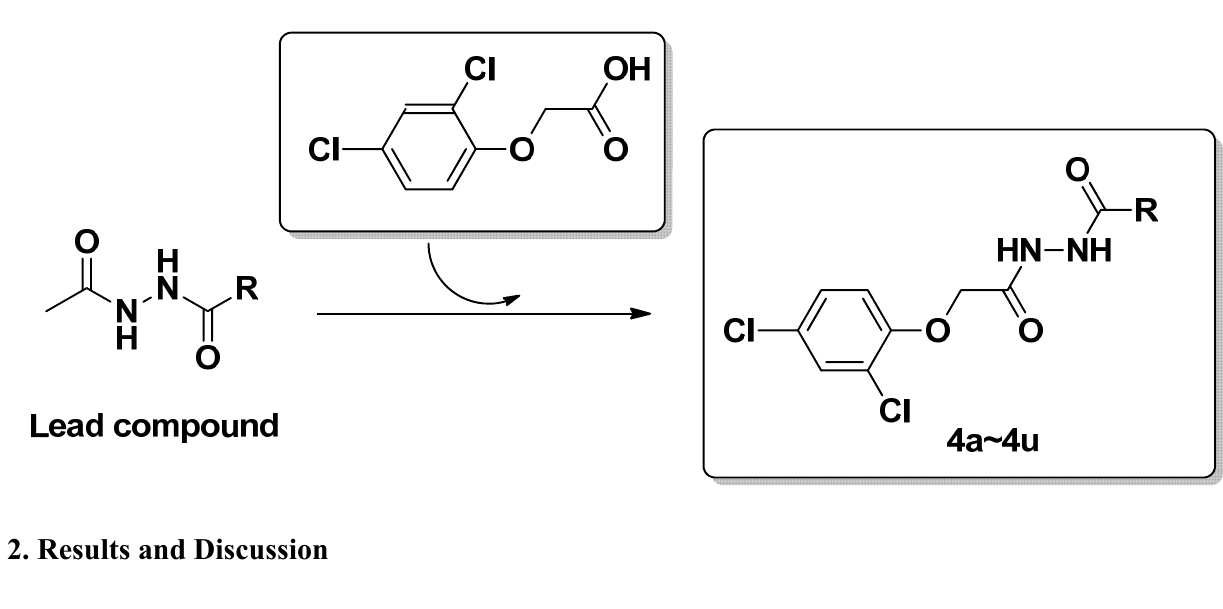
Figure 2. Design strategy of title